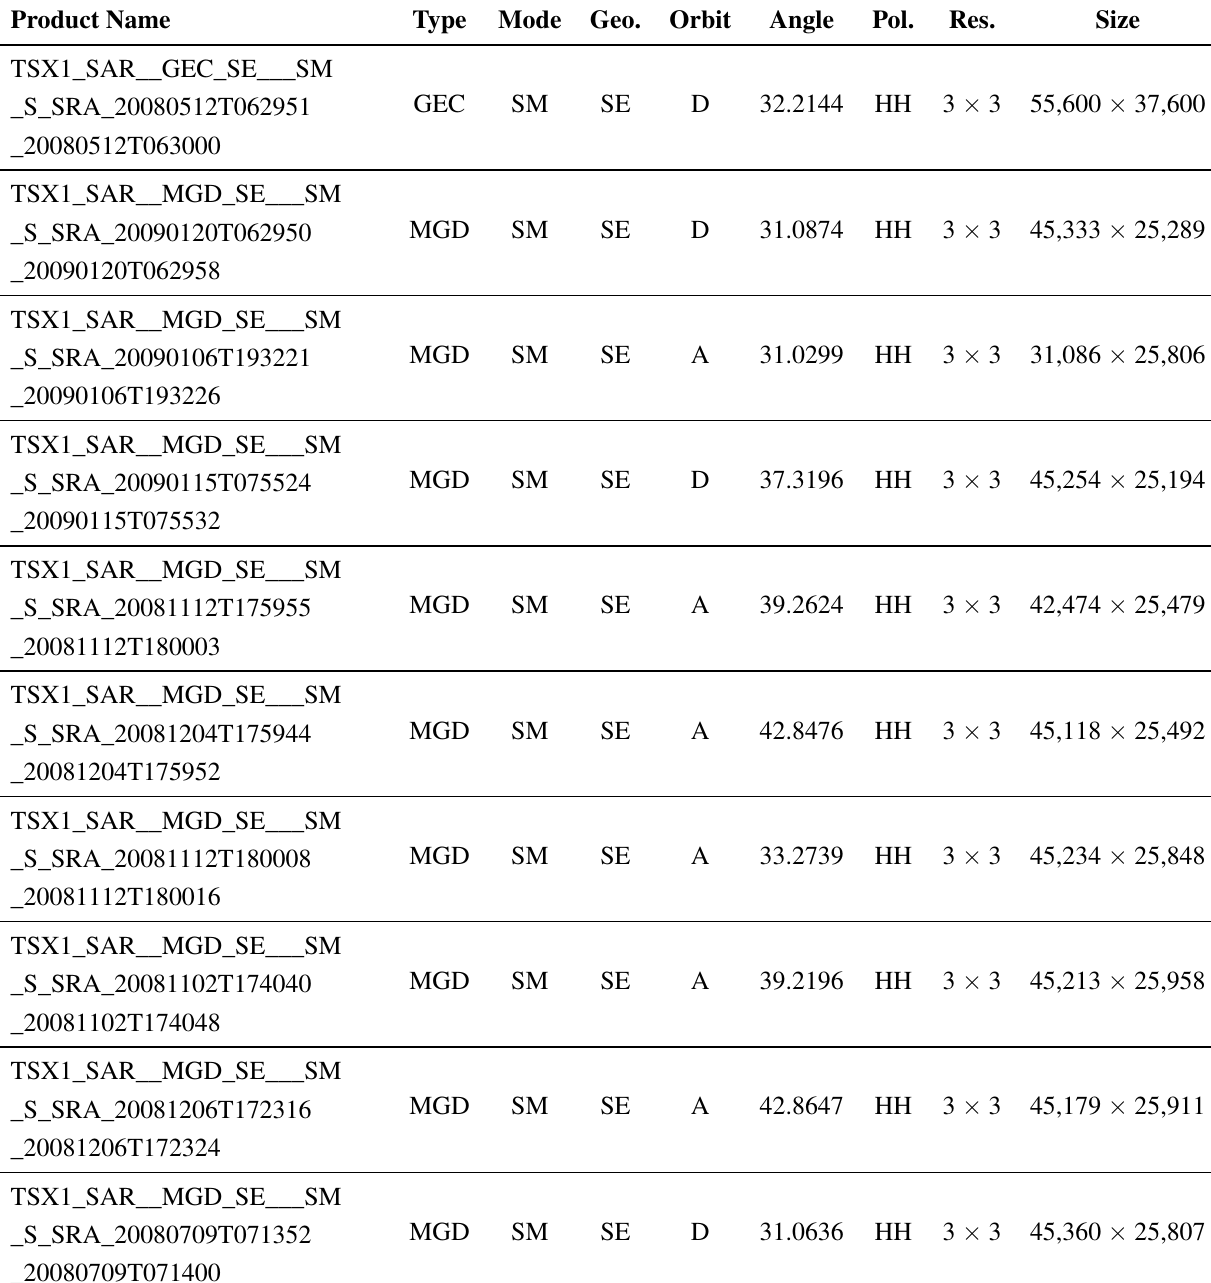
Table 2. TerraSAR-X images used to perform the classification (Geo., geometric resolution; Pol., polarization; Res., ground range resolution (m) × azimuth resolution